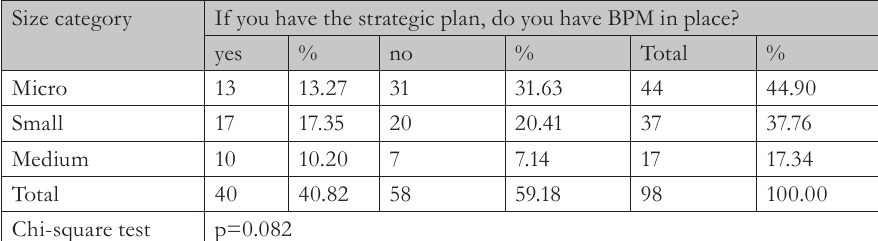
Tab. 3 – Classification of enterprises according to the relationship between the strategic plan and BPM system. Source: own